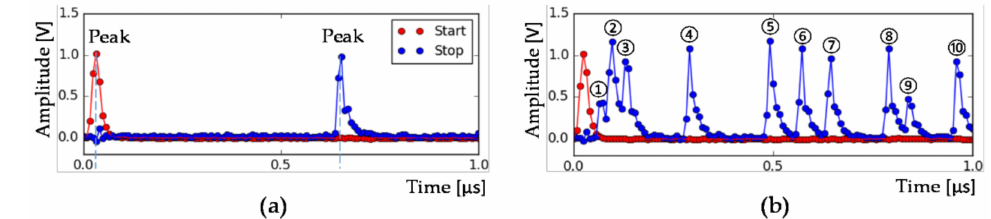
Figure 7. Signal detection by peak method in one cycle: ( a ) signals received at night; ( b ) signal with strong background light intensity appears 10 stop pulses.